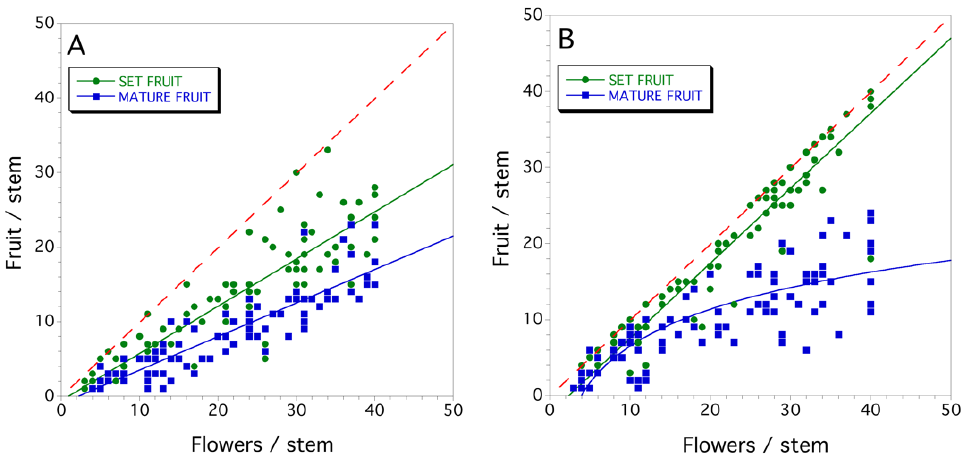
Figure 6. Relationships between wild blueberry flower density and set fruit densities and harvested (mature ripe) fruit in eastern Maine, USA: ( A ) Clone #1; and ( B ) Clone #2. The red dashed line is the 1:1 slope where no fruit drop occurs (flowers / stem = set fruit / stem and mature fruit / stem).